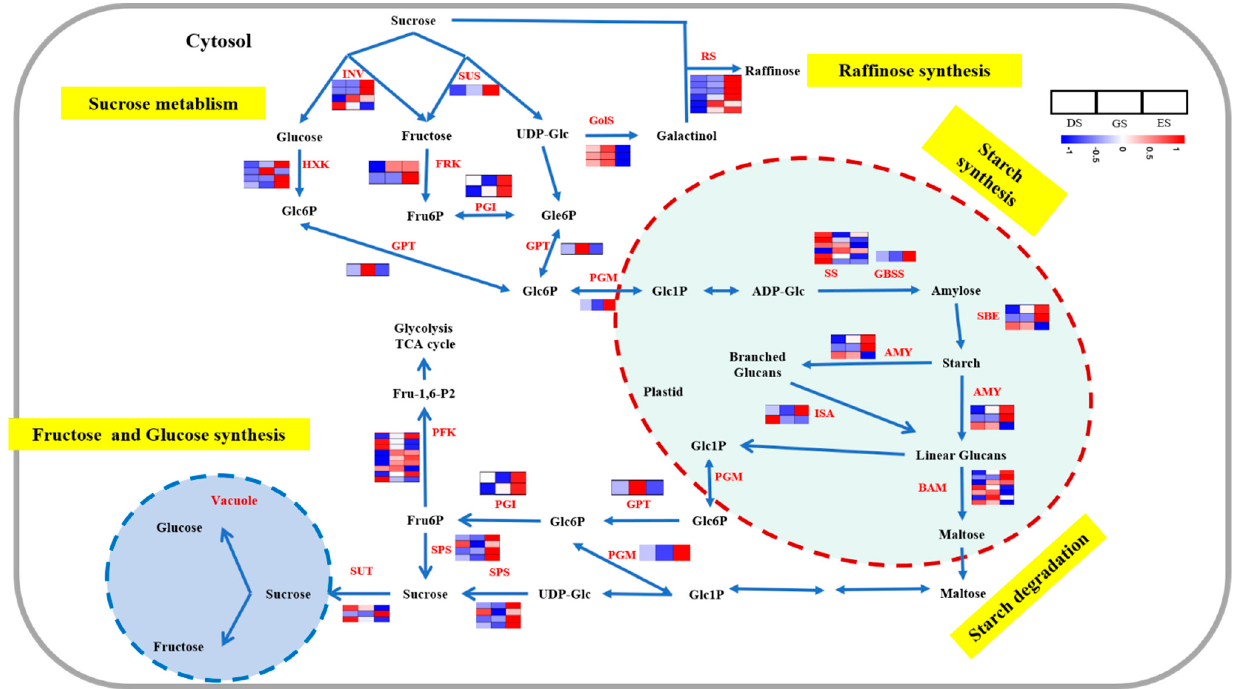
Figure 7. Expression profiles of DEGs involved in carbohydrate metabolism pathways in P. cyrtonema seeds during the germination process.